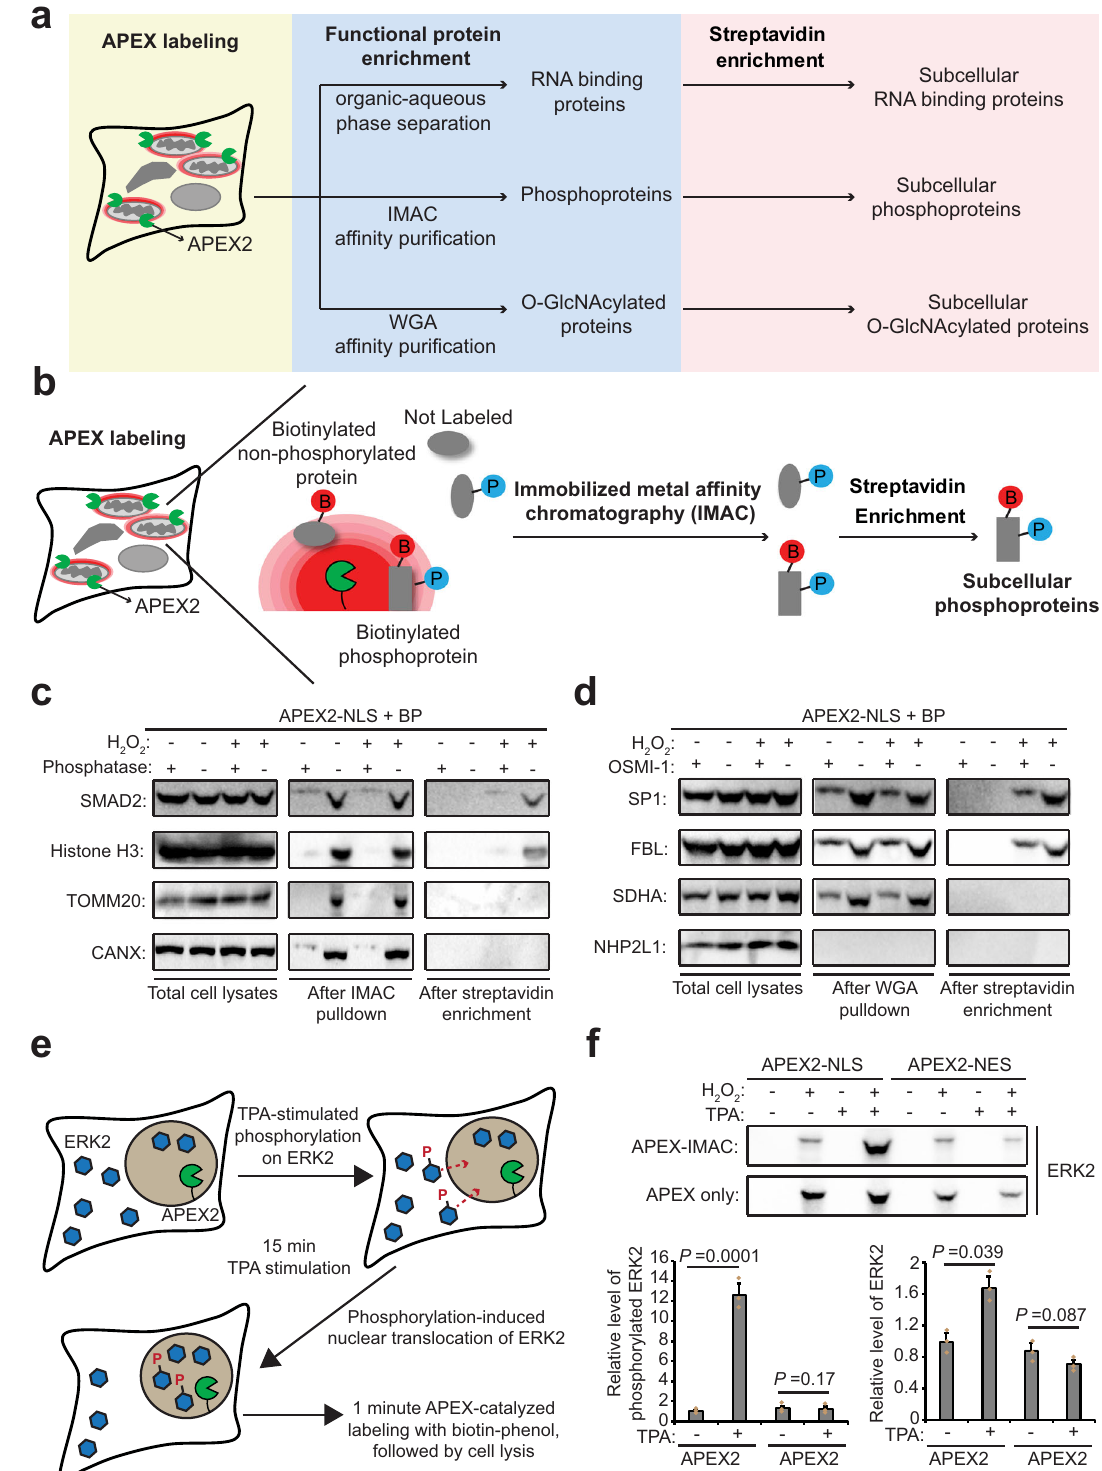
of the human proteome. Noncovalent RNA – protein interactions are pervasive in both transient and stable macromolecular com- plexes underlying transcription, translation, and stress response 16,41 . A spatiotemporally resolved approach for RBP dis- covery could yield valuable insights into organelle- or region- speci fi c questions concerning the dynamics of RNA – protein